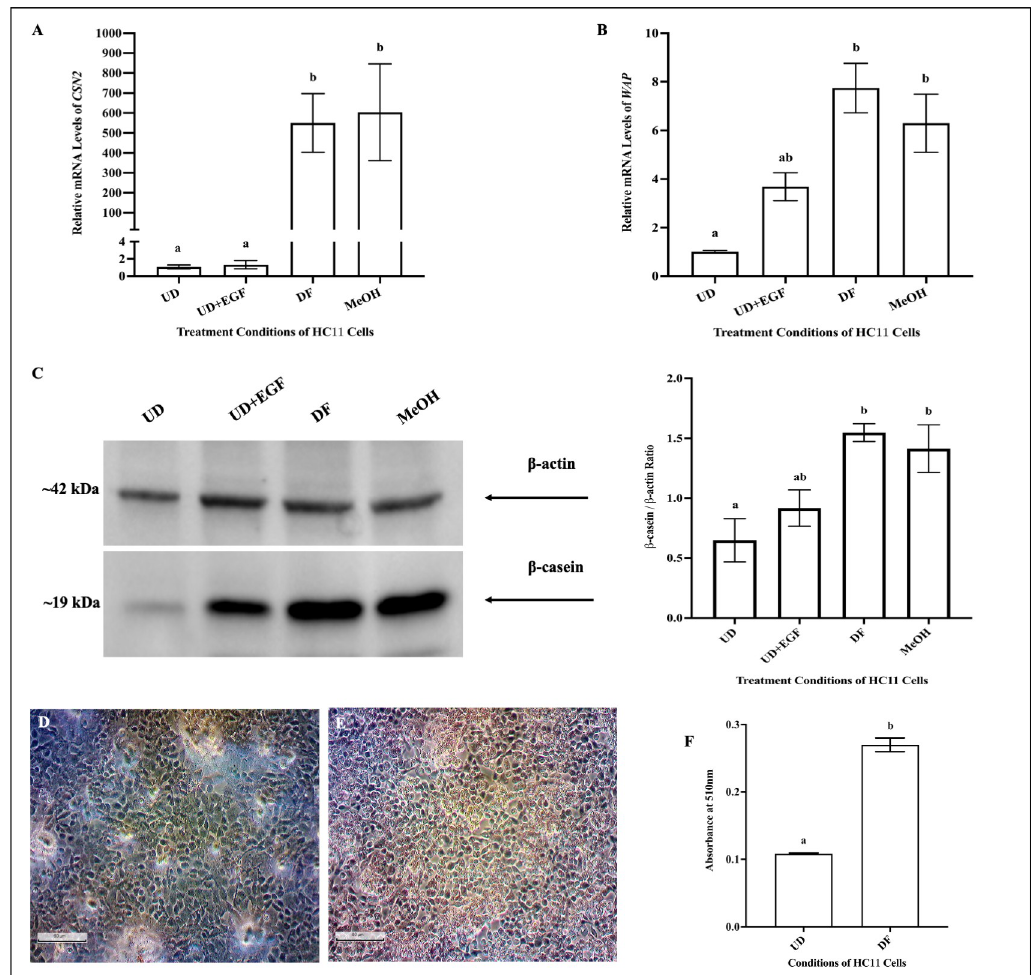
Fig 1. Differentiated HC11 cells displayed increased milk proteins and lipid levels. HC11 cells were seeded in base media for 24 hours (UD). HC11 cells were seeded and supplemented with EGF and INS for 3 days (UD+EGF). Finally, HC11 cells were differentiated in base media containing PRL, INS and DEX, and allowed to proceed for 4 days in the absence (DF) or presence of the vehicle (MeOH). Cells from all conditions were processed for total RNA or protein isolation, as described in methods. The relative (compared to RPL0 and RPL8 ) mRNA levels of CSN2 (A) and WAP (B) were determined. Gene expression analysis was repeated with 6 distinct replicates. Protein expression of β -casein was assessed, as described in methods, using 15 μ g of total protein for each sample. (C) A representative blot of β -casein expression is shown along with a bar graph quantifying its expression, normalized to β -actin, for undifferentiated (UD), EGF supplemented (UD+EGF), differentiated (DF) and differentiated in the presence of vehicle (MeOH), based on 4 replicates. Lipid levels were assessed in undifferentiated cells (UD) and differentiated cells (DF), by conducting an Oil Red O (ORO) assay, as described in methods. Representative images of ORO- stained undifferentiated HC11 cells (UD) and differentiated cells (DF), taken with a phase-contrast microscope (20x magnification). (F) Lipid levels were quantified in cells, as described in the methods, from 6 distinct replicates of undifferentiated HC11 cells (UD) and differentiated cells (DF). Results were plotted as mean ± SEM and compared using either a student’s t-test (for groups � 2), or one-way ANOVA (for groups � 3). Statistically significant changes were represented by distinct letters on bar